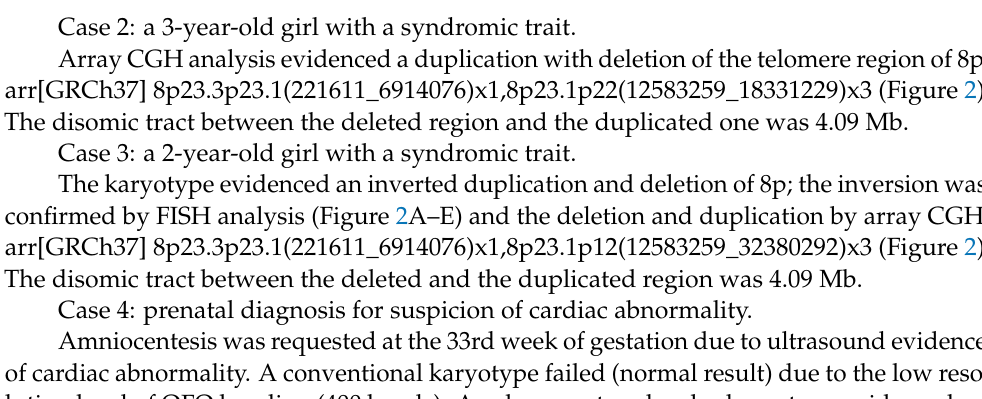
Figure 2. Upper panel: array CGH results of cases 1-3. Lower panel: Cytogenetics and FISH results of case 3. ( A ) QFQ-banded chromosome 8. ( B ) Partial metaphase after tricolor FISH with probes RP11-589N15 (blue signals), RP11-45016 (red signals), and RP11-139G9 (green signals). ( C ) Partial metaphase after dual-color FISH with probes RP11-589N15 (blue signals) and RP11-139G9 (green signals). ( D ) Partial metaphase after dual color FISH with probes RP11-45016 (red signals) and RP11-139G9 (green signals). ( E ) Array CGH ideogram showing the del inv dup(8p) region and the reciprocal mapping of FISH probes.